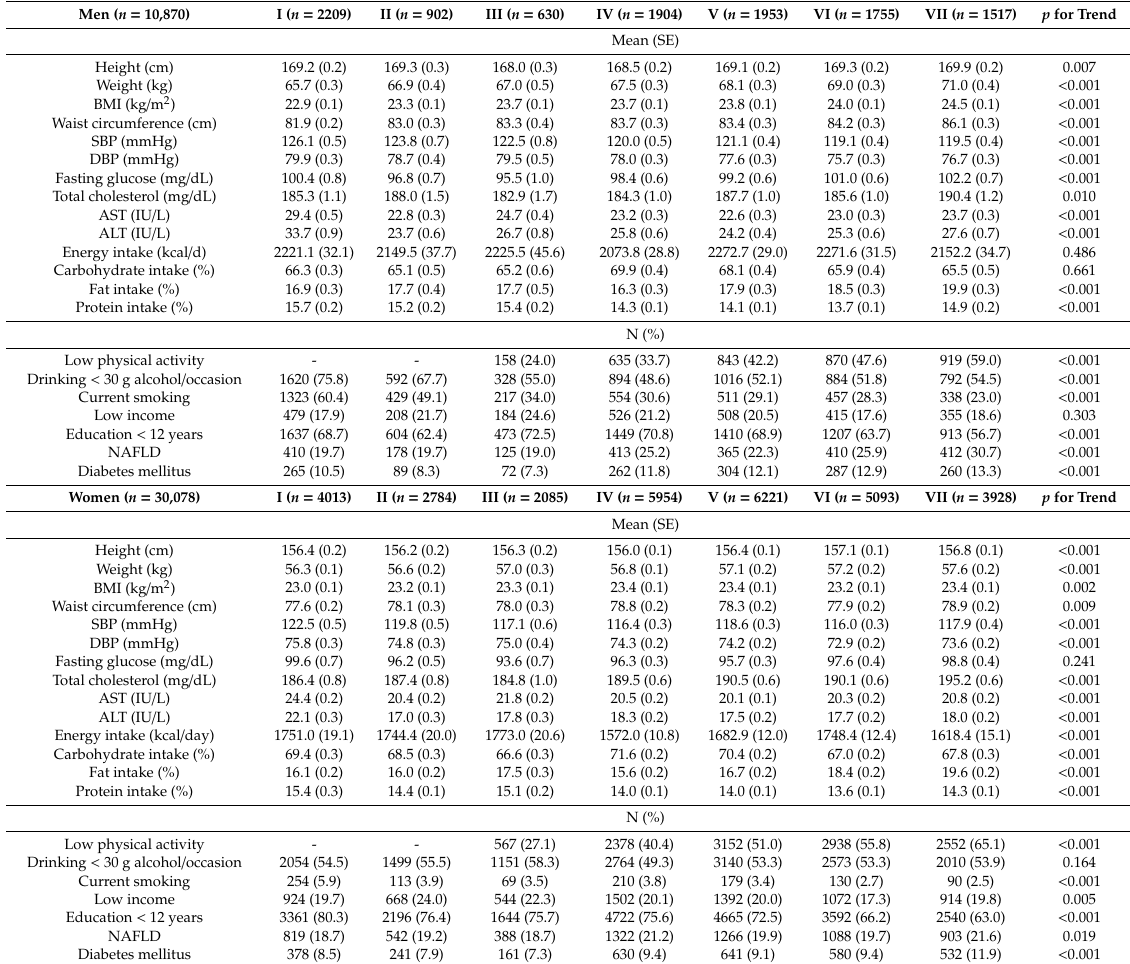
Table 1. Basic characteristics of 40,948 study participants, Korea National Health and Nutrition Examination Survey (KNHANES) waves